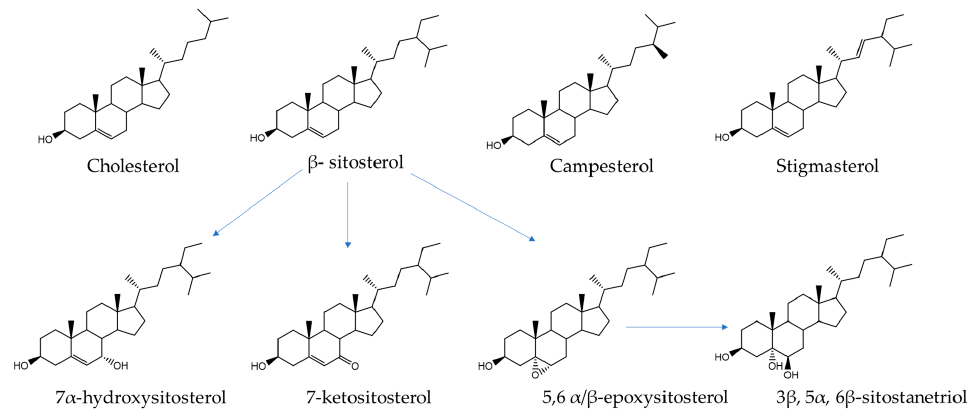
Figure 1. Chemical structures of cholesterol, principal plant sterols, and oxysterols.